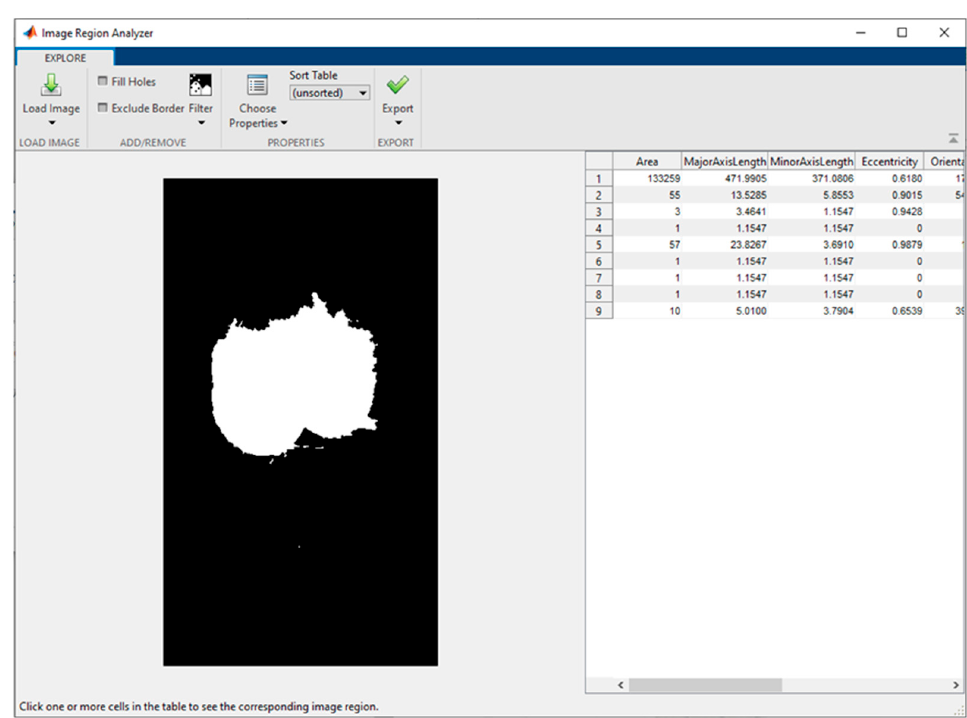
Figure 3. Analysis of the features of the segmented image of the area of interest .